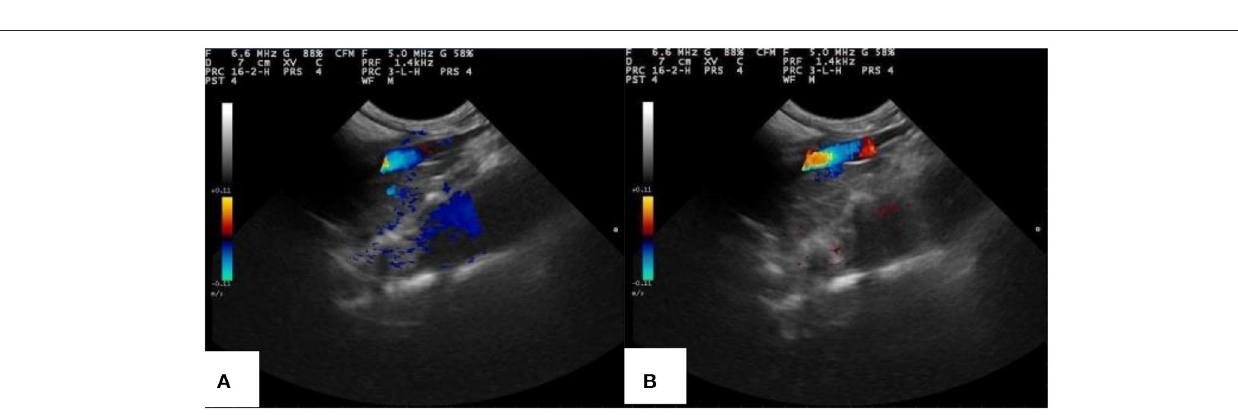
FIGURE 10 | Ultrasonic imaging of rabbit abdominal aorta of rabbits injected with PLA combined Fe 3 O 4 -GO-ASA nanobubbles (A) without the magnetic field (B) with the additional magnetic field in the thrombus